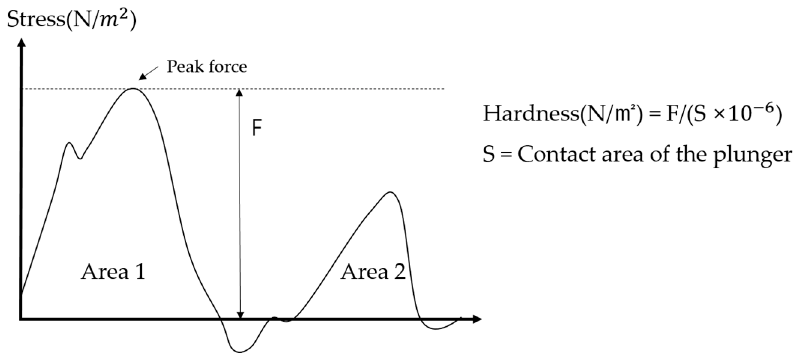
Figure 2. Diagram of Texture Profile Analysis (TPA) hardness measurement.